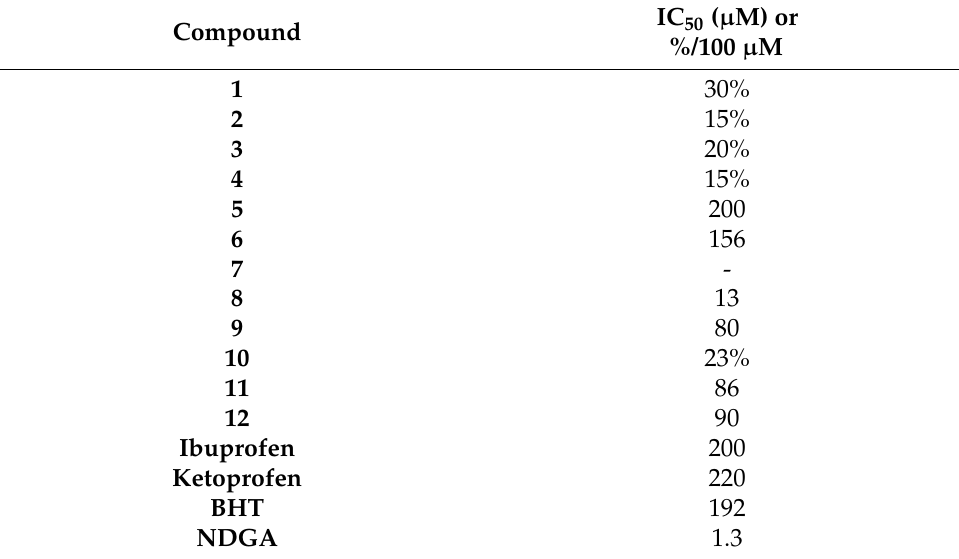
Table 4. Effect of compounds 1 – 12 , ibuprofen, ketoprofen, BHT and NDGA on lipoxygenase a